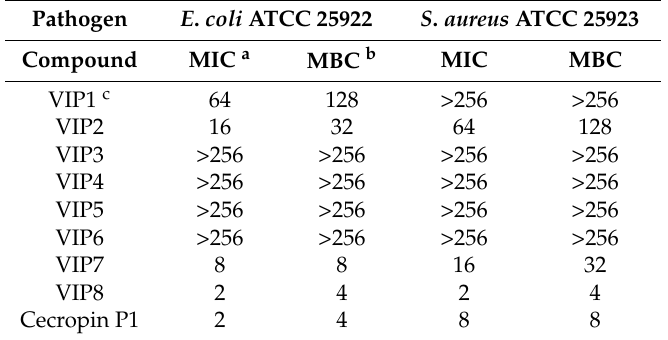
Table 2. Antimicrobial activity of VIP and its analogues. Microorganisms used were E . coli ATCC 25922 and S . aureus ATCC 25923. Cecropin P1 and blank (virgin media) were used as positive and negative controls.